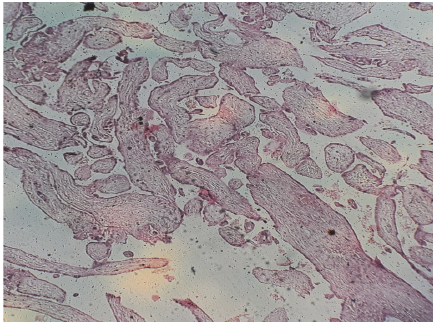
Figure 2: Products of conception (MVA). Chorionic villi in a 32- year-old woman who presented with bleeding per vaginam of 8 hours' duration.